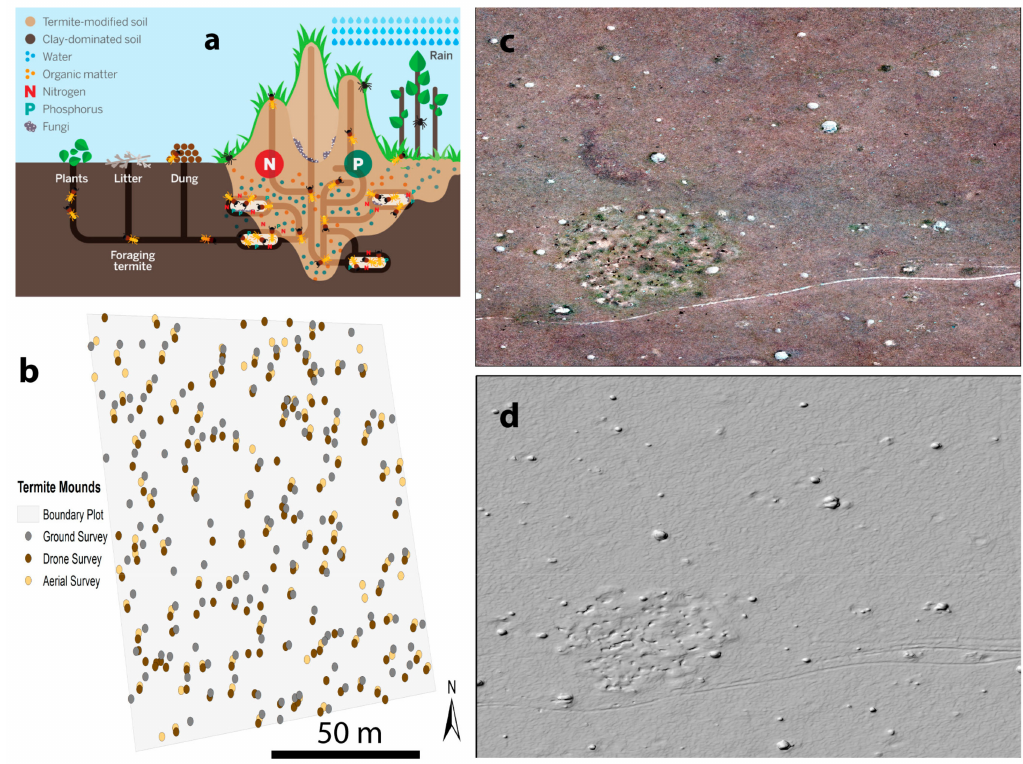
Figure 6. Spatial distribution of termite mounds across a 2,000 m 2 surveyed area of the Karoo, near Cradock (Figure 1 for location): ( a ) Architecture of a termite mounds [47]; ( b ) map using ground, drone and satellite image surveys; ( c ) ortho-mosaic; and ( d ) digital surface